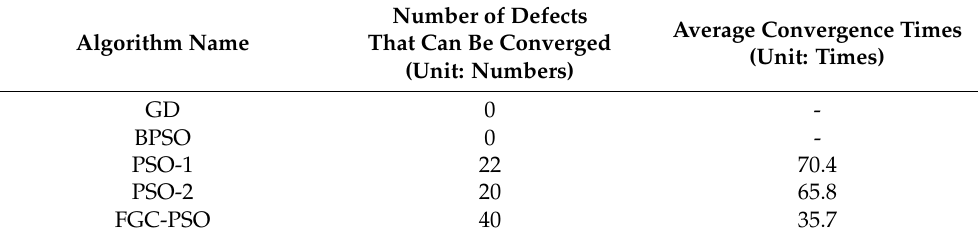
Table 4. Convergence statistical results of 40 defects with 15